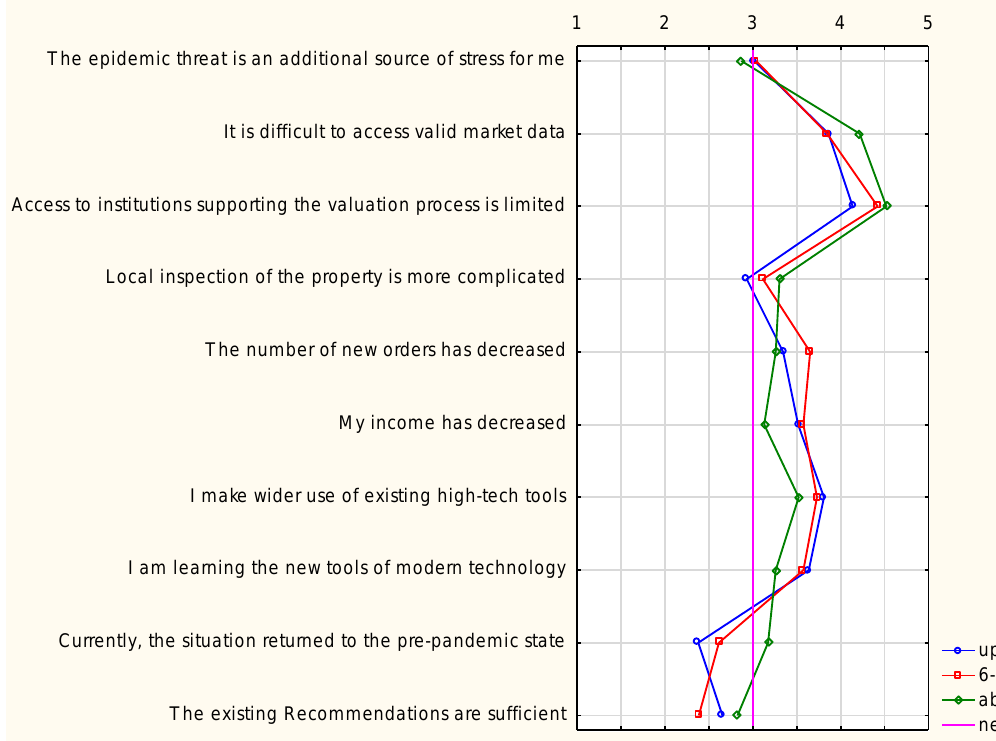
Figure 5. The means of respondents’ answers in groups by number of valuations per month.